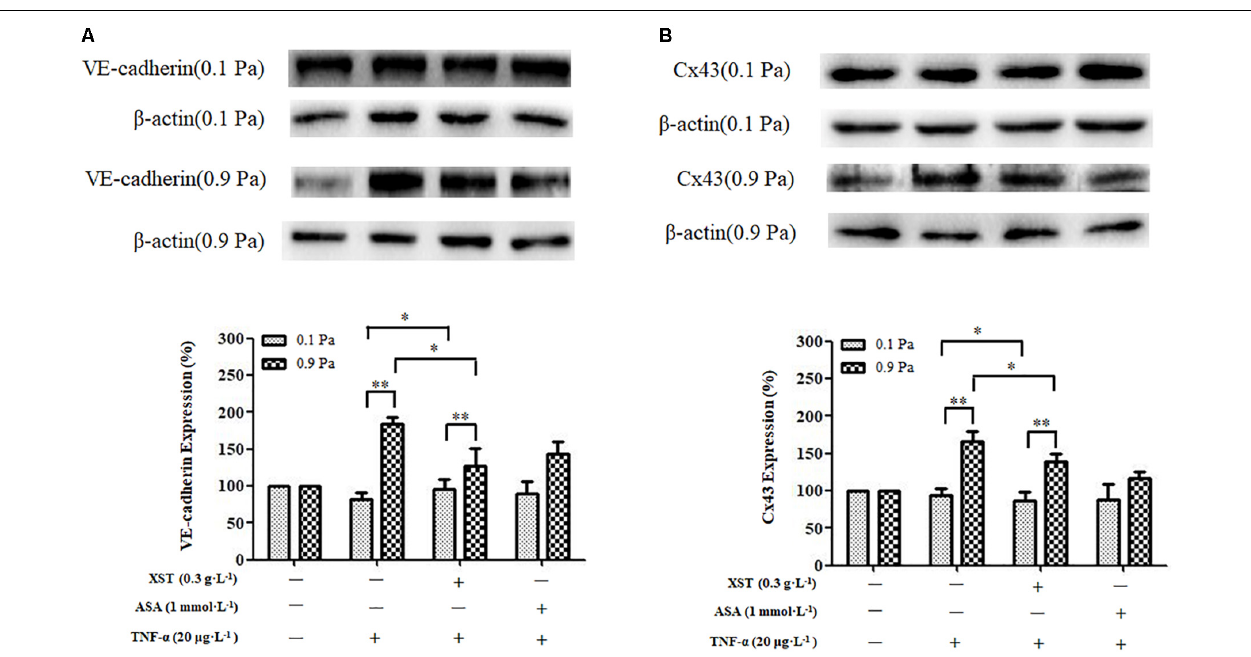
FIGURE 6 | Comparisons of VE-cadherin and Cx43 expression between groups under 0.1 and 0.9 Pa flow conditions. (A) The expression and density of VE-cadherin under 0.1 and 0.9 Pa flow conditions were analyzed by western blotting. (B) The expression and density of Cx43 under 0.1 and 0.9 Pa flow conditions were analyzed. The data was presented as means ± SD, n = 3; data was analyzed by two-way ANOVA as described in Methods; analysis of simple effects. ∗∗ P < 0.001; ∗ P <